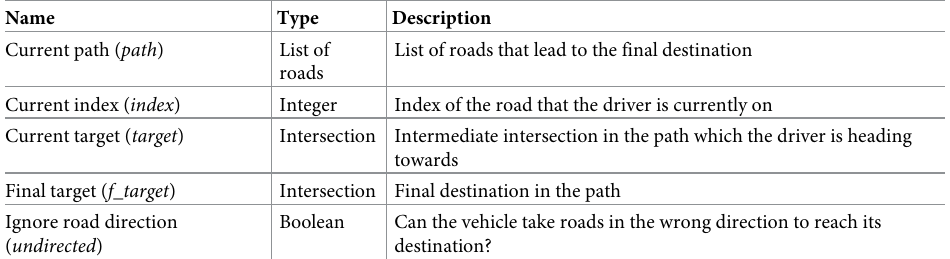
Table 4. Attributes of the vehicle entities related to path